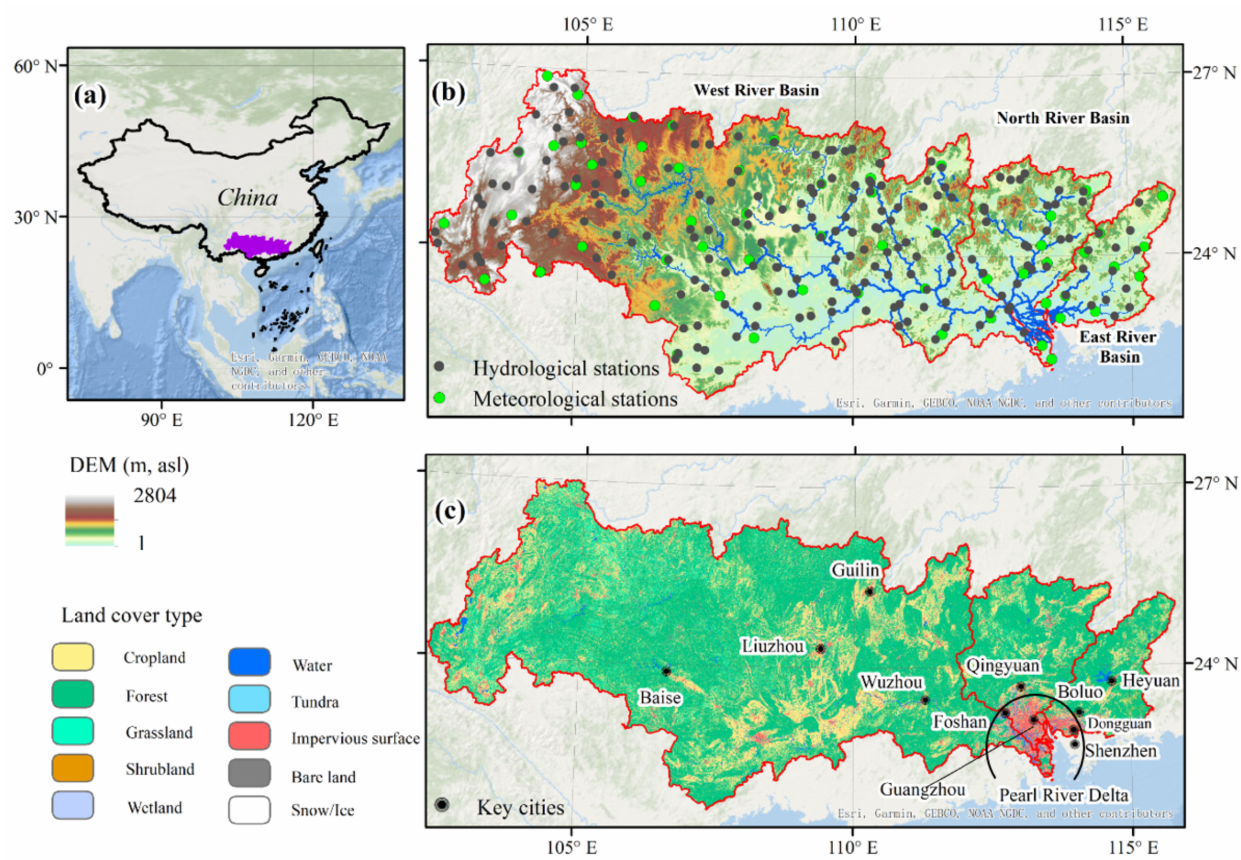
Figure 1. ( a ) Location of the Pearl River Basin (PRB) in China; ( b ) the distribution of meteorological stations and hydrological stations; ( c ) key cities in PRB and the land cover in PRB (circled region represents the Pearl River